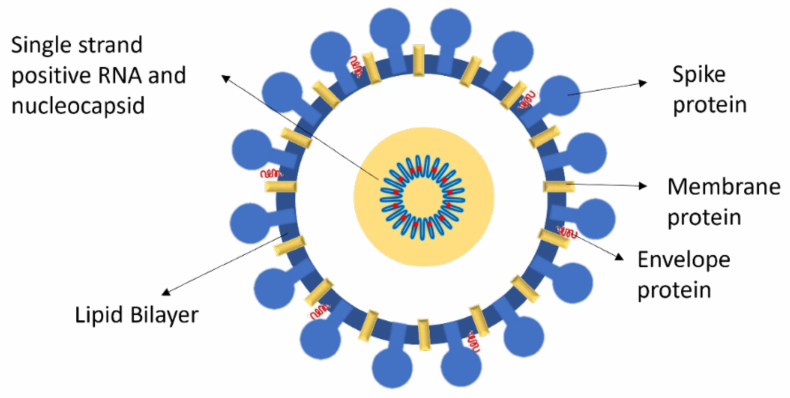
Figure 1. Representation of SARS-CoV-2 main structural